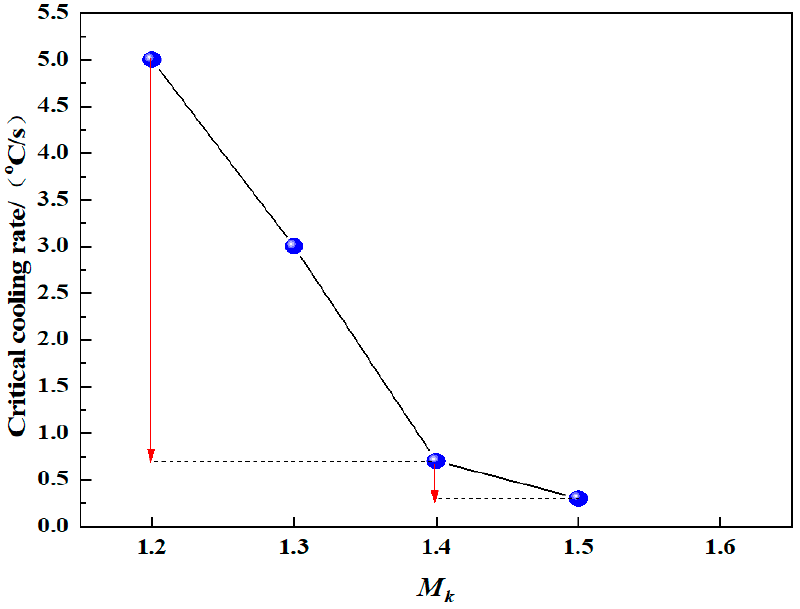
Figure 9. The influence of the M k value of the modified blast furnace slag on its critical cooling rate.